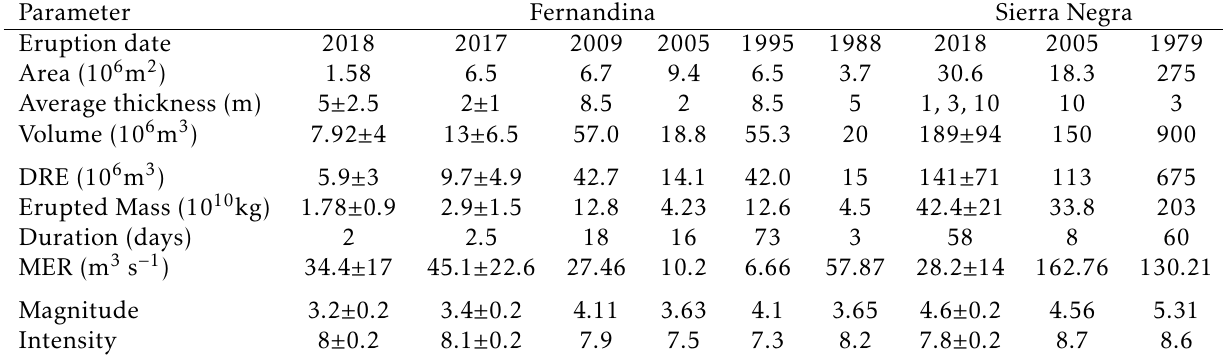
Table 1 – Comparison of the size of the eruptions of Fernandina and Sierra Negra volcanoes. The parameters were taken from Bourquin et al. 2009 (2009-eruption), Chadwick et al. 2011 (2005), Rowland et al. 2003 (1995), Chadwick et al. 1991 (1988) in the case of Fernandina and from Geist et al. 2008 (2005-eruption) and Reynolds et al. 1995 (1979) in the case of Sierra Negra. Moreover, based on past literature an average thickness ( ± 50% error), a rock density of 3000 kg m − 3 and deposit density (25% void) were